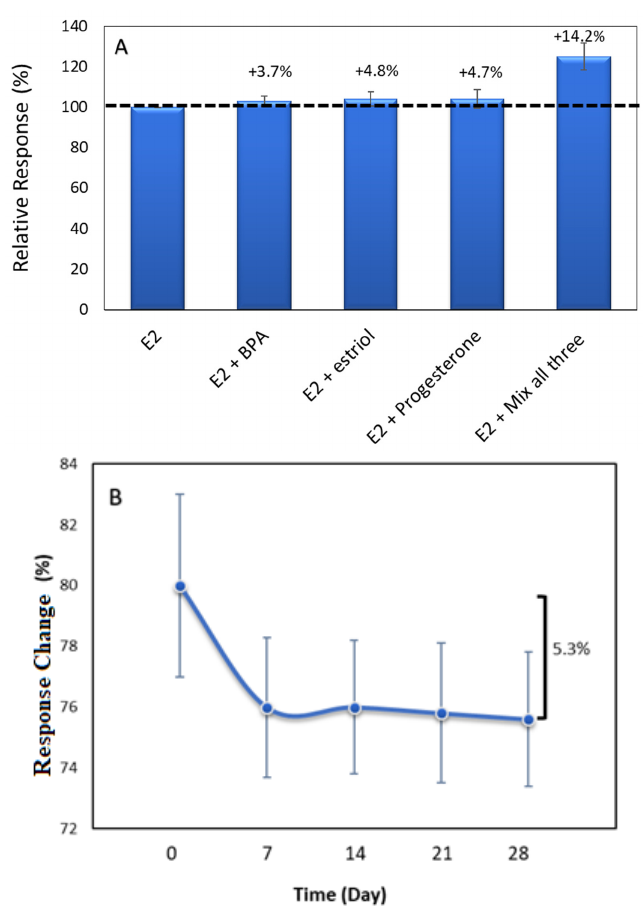
Figure 5. ( A ) Specificity of the EIS aptamer biosensor toward E2. ( B ) Stability studies were taken at one-week intervals.